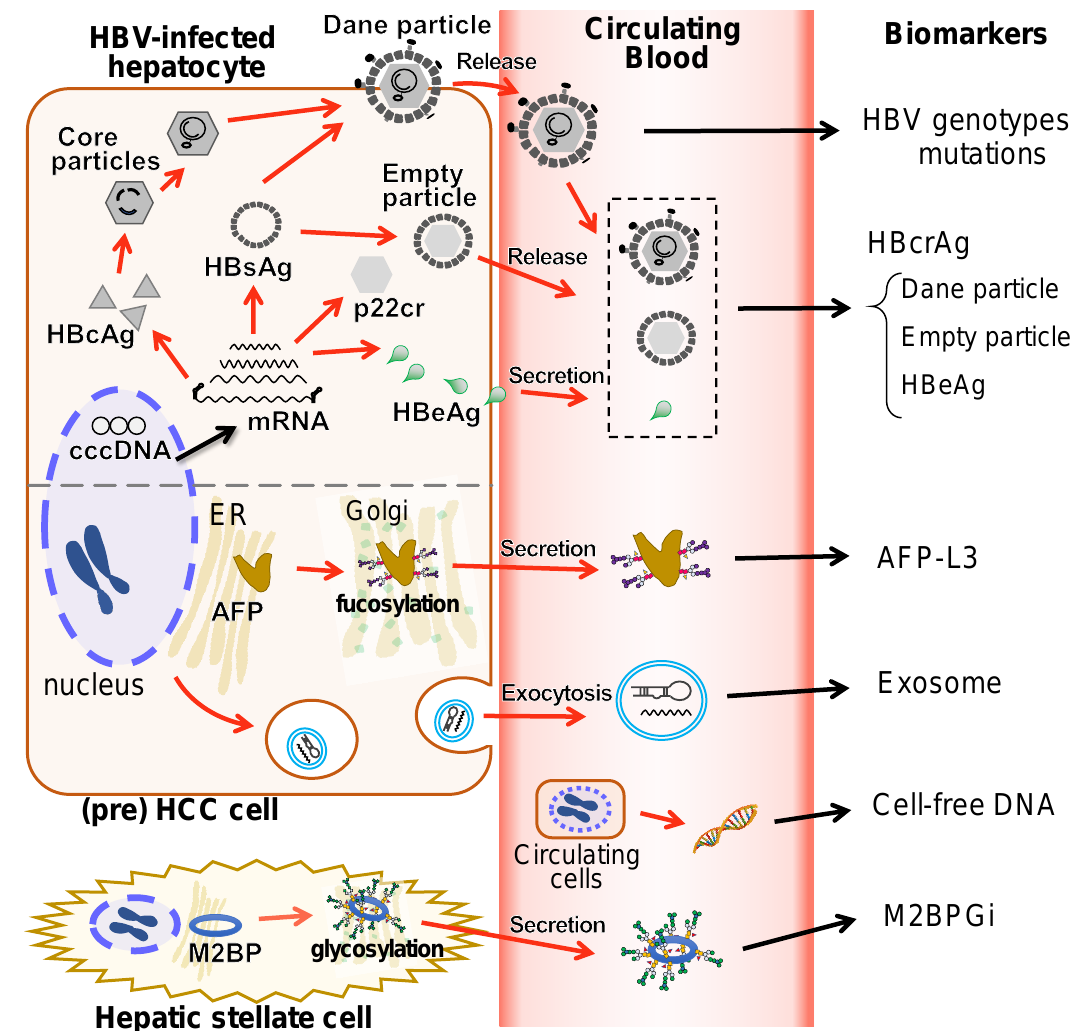
Figure 3. Blood-based biomarkers and their intracellular sources. The schematic diagram shows the link between the blood-based biomarker and the intracellular molecules targeted by each biomarker in HBV-related HCC patients. HBV genotypes/genome mutations are associated with disease progression. HBcrAg consisting of HBcAg, empty particles and HBeAg would correlate to cccDNA, that higher persistent HBcrAg levels are associated with the risk of HCC development with HBV infection. Dane particles refer to infectious complete virions, which have HBcAg inside them. HbeAg crosses the hepatocyte membrane. Both empty particles and HBeAg are released or secreted into the bloodstream in the processes separate from the Dane particles. AFP-L3 is a fucosylated AFP secreted into the bloodstream and can bind to LCA lectin. Fucosylated AFP levels correlates with the poor prognosis of HCC. Exosomes are a subtype of extracellular vesicles that encapsulate microRNA or messenger RNA and are released from cells into the bloodstream by exocytosis. Cell-free DNA in blood derived from the broken circulating HCC cells could be useful for an early detection of HCC. M2BPGi is a M2BP glycosylation isomer and is thought to be secreted from hepatic stellate cells. M2BPGi levels are reportedly associated with the risk of HCC development with HBV infection. HBV, hepatitis B virus; HCC, hepatocellular carcinoma; HBcrAg, hepatitis b core-related antigen; HBsAg, hepatitis B surface antigen; HBcAg, hepatitis B core antigen; p22cr, 22-kDa pre-core protein; HBeAg, hepatitis B e antigen; cccDNA, covalently closed circular DNA; AFP, alpha-fetoprotein; LCA, Lens culinaris (Lentil) Agglutinin; mRNA, messenger RNA. M2BP, Mac-2 binding protein. Among naïve CHB patients, serum HBcrAg levels are significantly higher in HBeAg- positive than in HBeAg-negative and are correlated to not only serum HBV DNA levels, but also intrahepatic HBV DNA and pgRNA, besides both intrahepatic cccDNA levels and its transcriptional activity [75]. Moreover, serum HBcrAg levels are reportedly